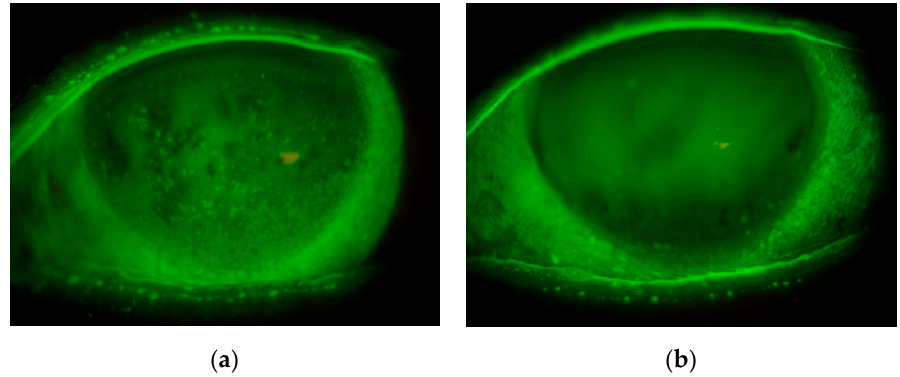
Figure 1. Representative case of a 72-year-old woman treated with intense pulsed light-meibomian gland expression. Slitlamp images of fluorescein staining of the left eye obtained before ( a ) and 3 months after completion of ( b ) treatment showed amelioration of central corneal epitheliopathy. The logMAR visual acuity also improved from 0.15 to 0.09 in association with improvement in the lipid layer of the tear film, whereas tear meniscus height was unchanged.